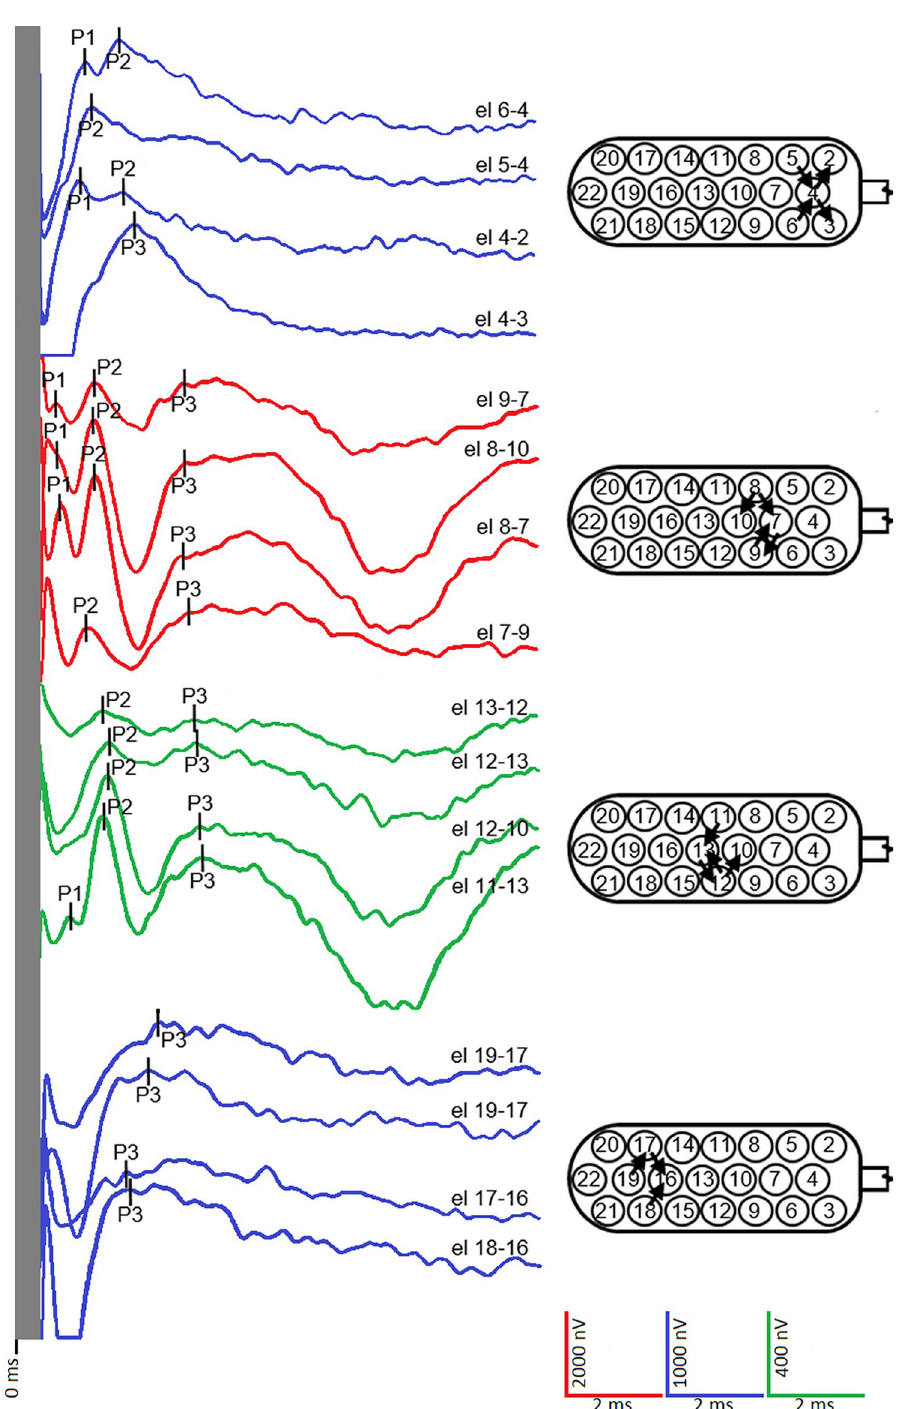
Fig 3. EABRs obtained with the modified protocol (MP) for patient CH7. The electrode combinations have narrower stimulation arcs compared to CP (Fig 2) by reducing the electric field and interactions between electrodes, which allows for better interpretation of electrode position. In general, there are a greater number of 3-peak waveforms than with CP (Fig 2). Stimulation artifacts present in the first 0.5 ms of recording have been eliminated. el, electrodes.